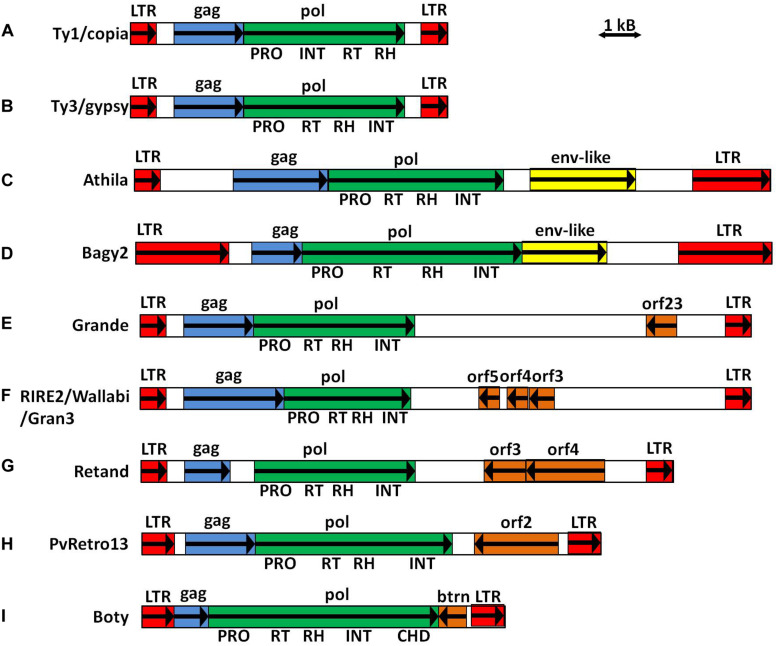
Schematic representation of LTR-retrotransposons. (A) Model Ty1/copia element. (B) Model Ty3/gypsy element. (C)
Arabidopis thaliana Athila (Wright and Voytas, 2002). (D) Barley Bagy2 (Vicient et al., 2001). (E) Maize Grande (Gómez-Orte et al., 2013). (F) Rice RIRE2 (Ohtsubo et al., 1999), Wallabi and Gran3 (Wicker et al., 2007). (G)
Silene latifolia Retand (Kejnovsky et al., 2006). (H)
Phaseolus vulgaris PvRetro13 (Gao et al., 2014). (I)
Botrytis cinerea Boty (Zhao et al., 2011).